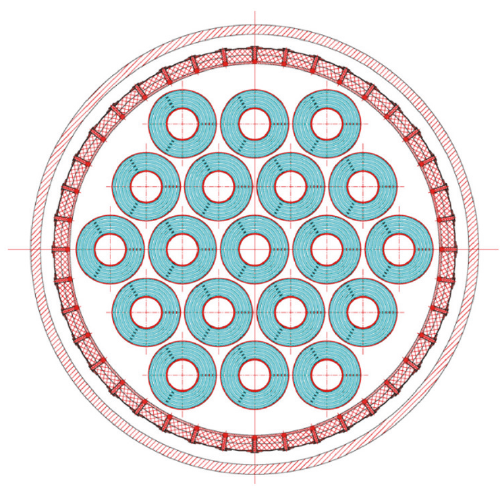
Figure 7: Cross section of a steam generator with 19 assemblies [11].